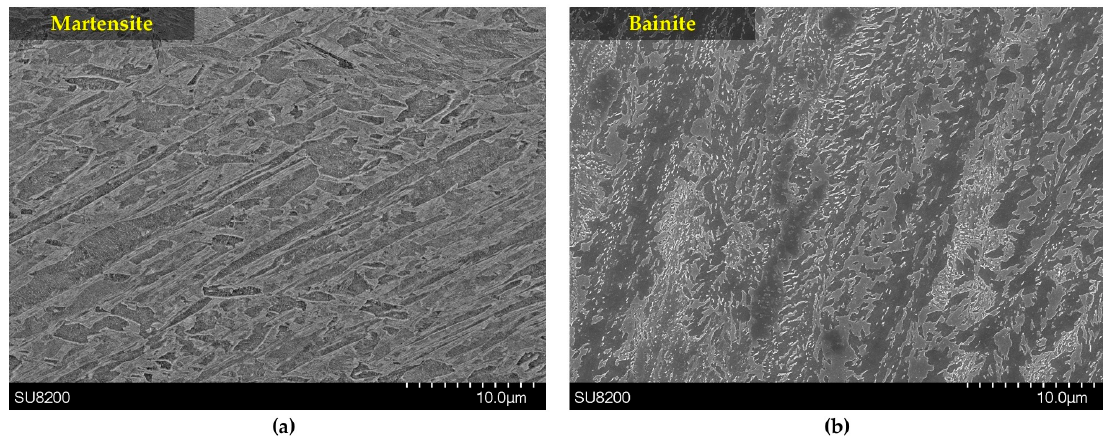
Figure 2. As-cooled microstructures obtained for different cooling rates: ( a ) Martensitic microstructure, 180 °C/min and ( b ) bainitic microstructure, 4.8 °C/min.